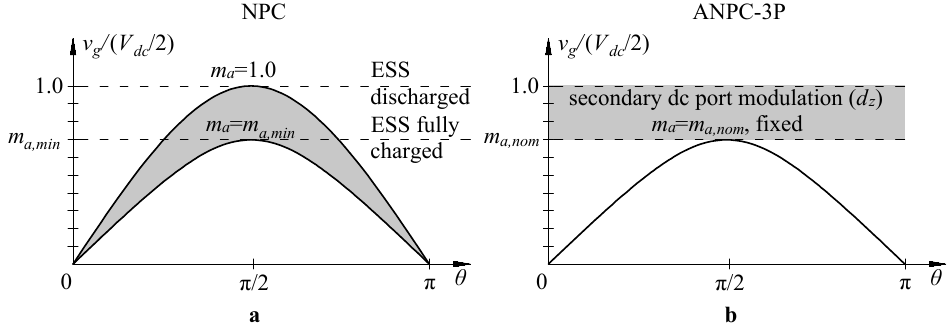
Figure 5. Modulation regions considering ESS state of charge (SOC) variation: ( a ) dedicated NPC inverter and ( b ) ANPC-3P